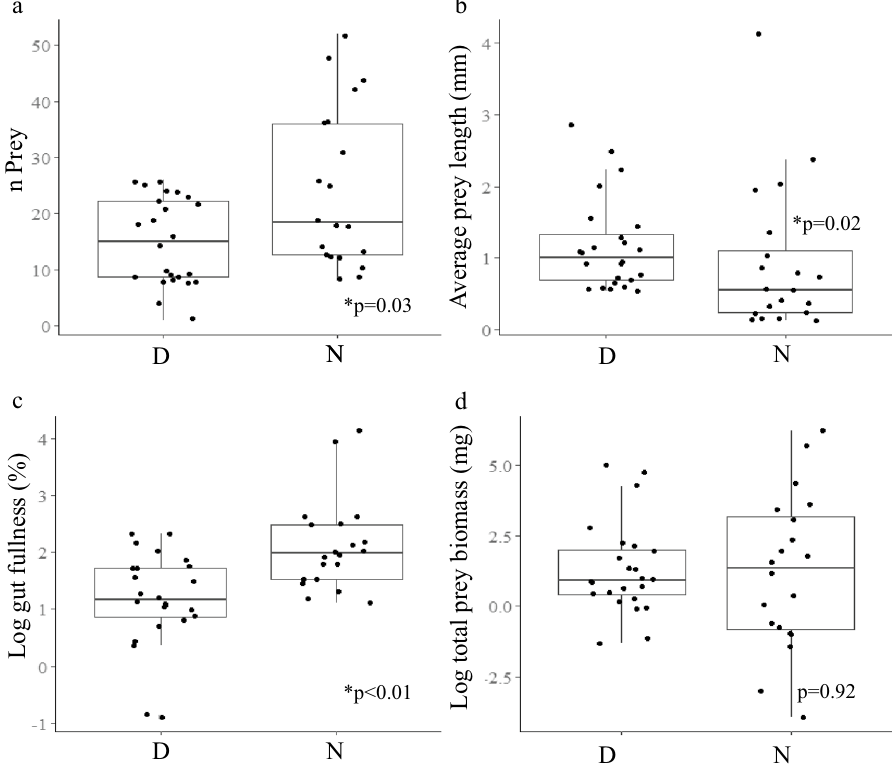
Figure 7. Boxplots showing differences between guts measured during day (D) and night (N) and ( a ) number of prey per gut ( p = 0.03, U = 148), ( b ) average prey length ( p = 0.02, U = 334) ( c ) percent gut fullness, log transformed ( p < 0.01, U = 93), and ( d ) total prey biomass per gut, log transformed ( p = 0.92, U = 245). Thick horizontal lines within each box show median values, vertical lines on either side of each box show standard error, dots represent outliers.